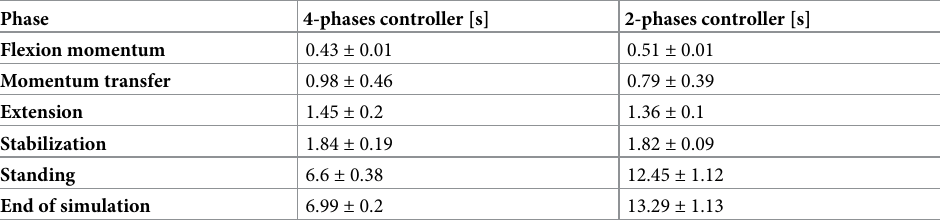
Table 7. Comparison between 4-phases controller and 2-phases controller along the STS